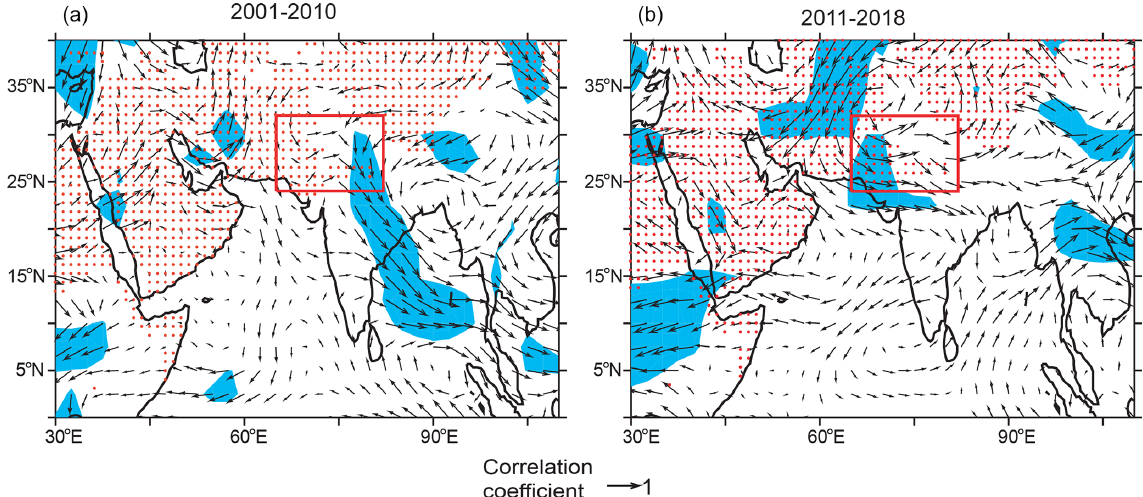
Figure 9. Correlation between the April–June North Atlantic difference index (NADI) and wind averaged over 700–850hPa for May– September for (a) 2001–2010 and for (b) 2011–2018. Light blue shading highlights the regions where one of the components of the wind vector is significantly (at the 95% confidence level) correlated with the NADI. Red stippling show dust emission regions obtained from CESM model simulations, and the red square encloses the South Asian dust belt considered in this